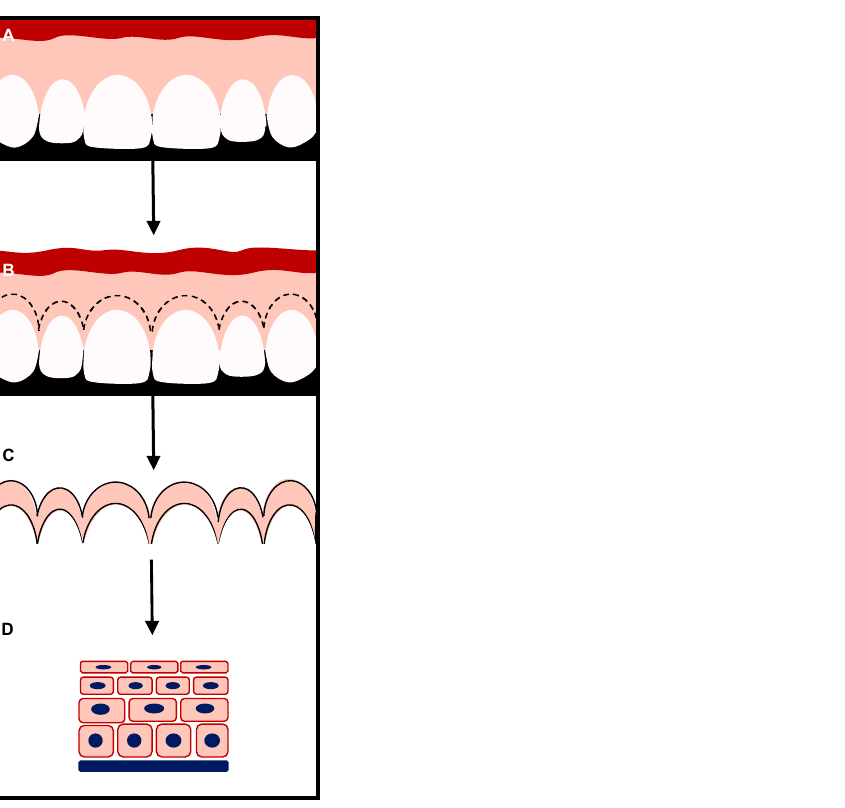
Figure 1. Study design. ( A ) Patients with type 1 altered passive eruption (APE) were selected. ( B ) After 6 months of supervised plaque control and uninterrupted gingival clinical health, patients were surgically treated. Submarginal and sulcular incisions were performed. ( C ) The gingival collar comprising the gingival margin was removed and fixed in 10% neutral buffered formalin. ( D ) The excised tissue was histologically analyzed.